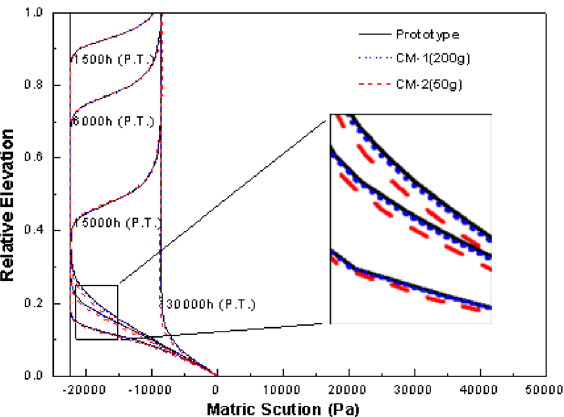
Figure 9. Numerical verification of the feasibility for centrifuges to be applied to model unsaturated flow using Hydrous 1-D software package, where prototype refers to the prototype model and CM represents centrifugal